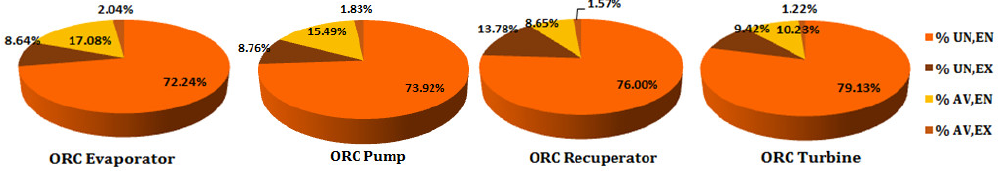
Figure 6. Advanced exergo-economic destruction rate of each component in the solar – geothermal cycle (SGPP). The results of the advanced exergo-environmental analysis ̇  , for the GPP cycle are presented in Figure 7. In the best state of operation, there will be exergo-environmental destruction of about 80%–90%. The avoidable exergy destruction of the turbine (about 11%) and ORC pump (about 10%) was the highest. It is possible to reduce about 10% of the environmental destruction of exergy using modification. The highest environmental impact of the exogenous exergy destruction rates of the equipment was about 15% for the ORC recuperator. This showed that the system components had